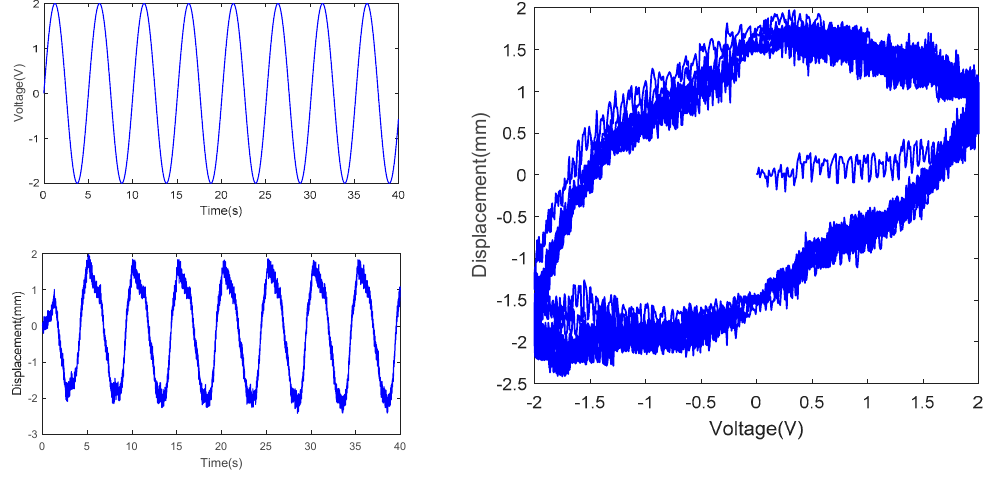
Figure 7. Tip displacement at actuating voltage with amplitude of 2V and frequency of 0.5/2 π Hz.